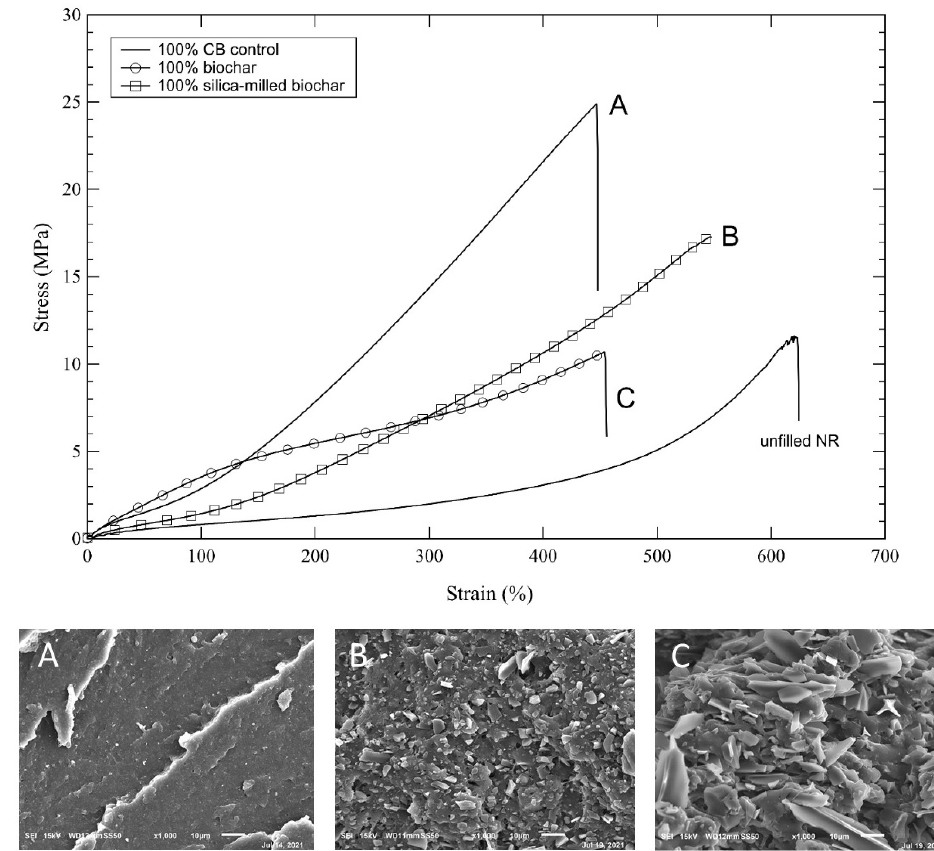
Figure 3. Tensile properties for: ( A ) 100% CB filled control, ( B ) 100% silica-milled biochar, and ( C ) 100% biochar with no silica. Images ( A – C ) are SEM images at 1000 × of the three composite samples along their fractured surface after tensile testing. The small white bar in the lower right section of each SEM image represents 10 microns.